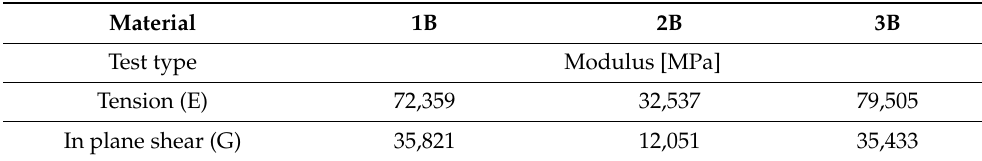
Table 2. The values of elastic constants obtained for 1B, 2B and 3B specimens.